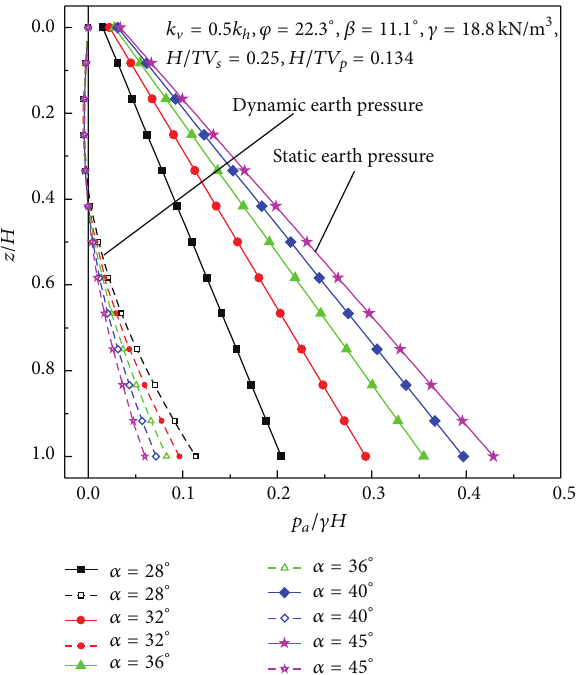
Figure 5: Comparisons of static and dynamic soil